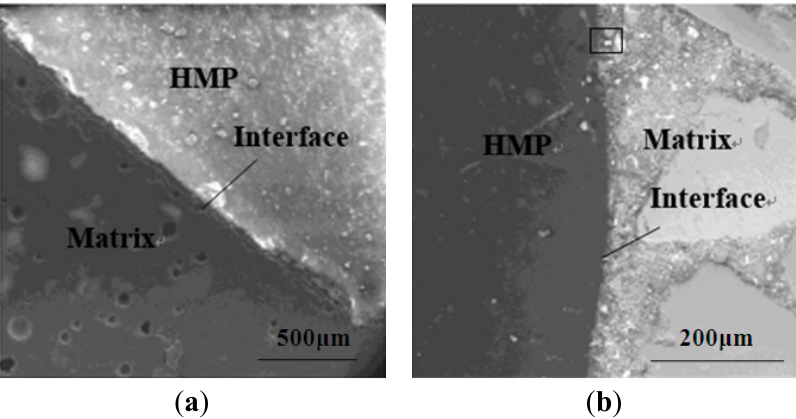
Figure 11. ESEM image of HMP mortars without heating and with 2-day heating. ( a ) HMP mortar without heating. ( b ) HMP mortar heated for 2